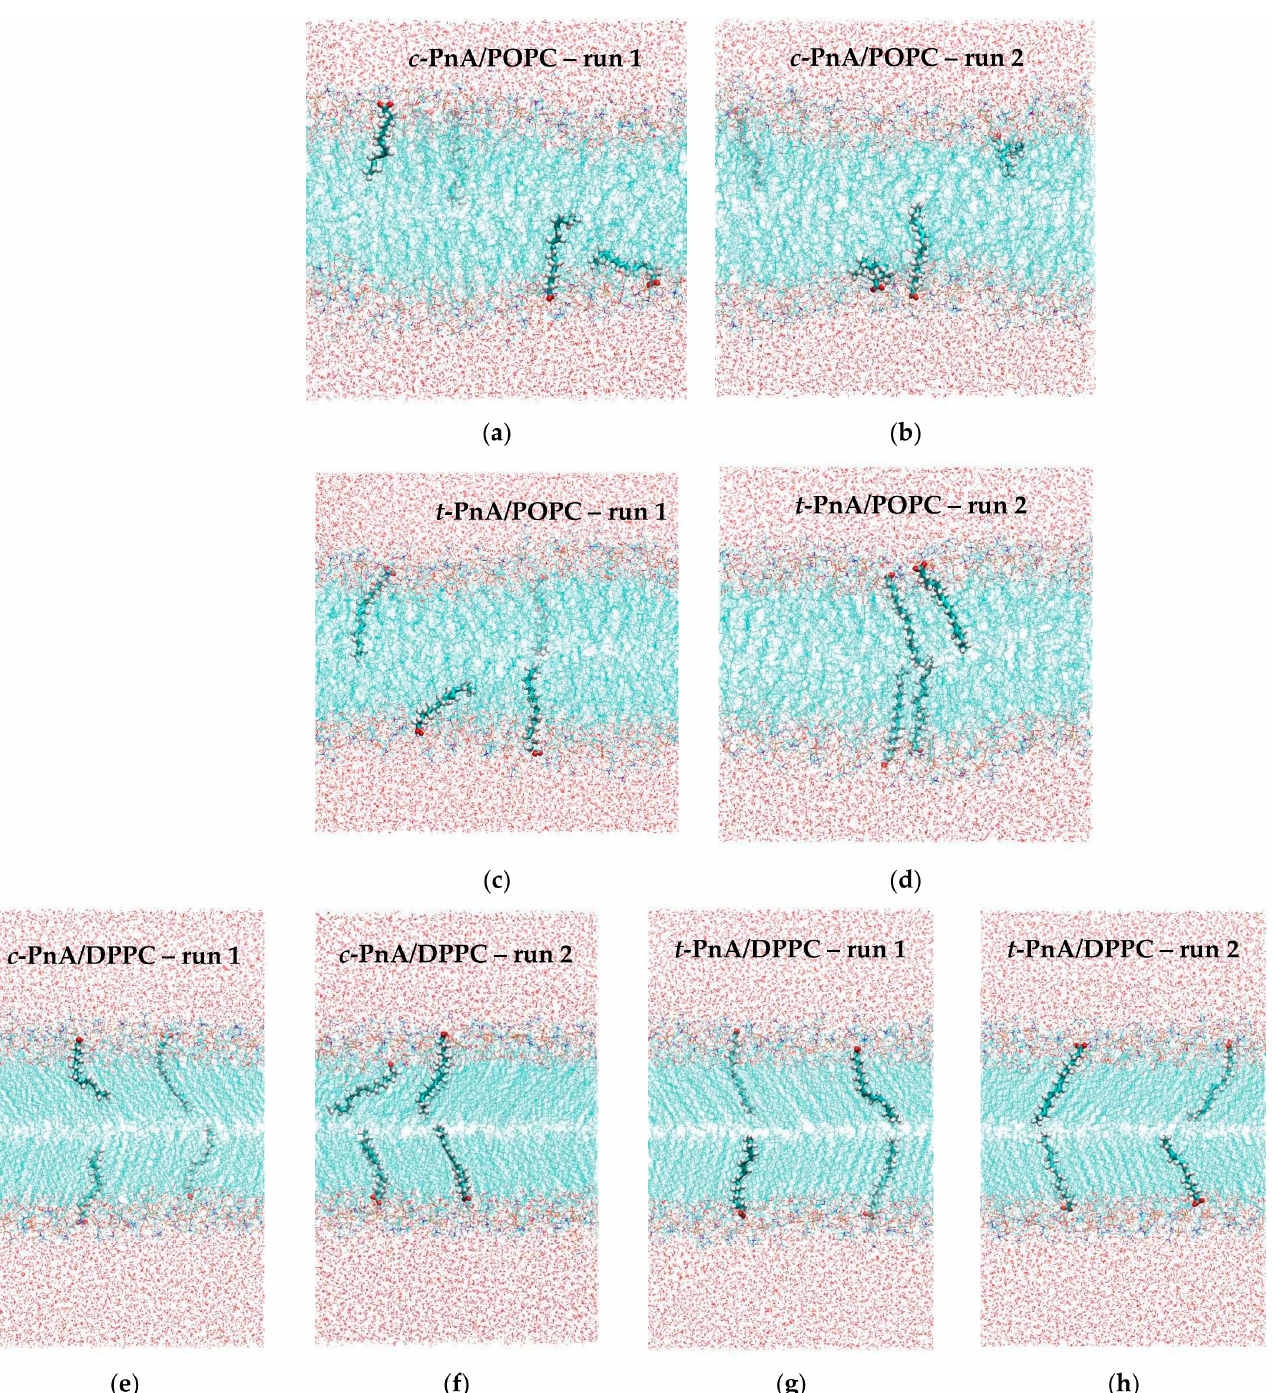
Figure 2. Final snapshots of the two runs of c ‐ PnA in POPC ( a , b ), t ‐ PnA in POPC ( c , d ), c ‐ PnA in DPPC ( e , f ) and t ‐ PnA in DPPC ( g , h ). For each lipid system, the four images are drawn on the same scale. However, for the sake of representation, the DPPC snapshots are drawn on a slightly reduced scale compared with the POPC ones.